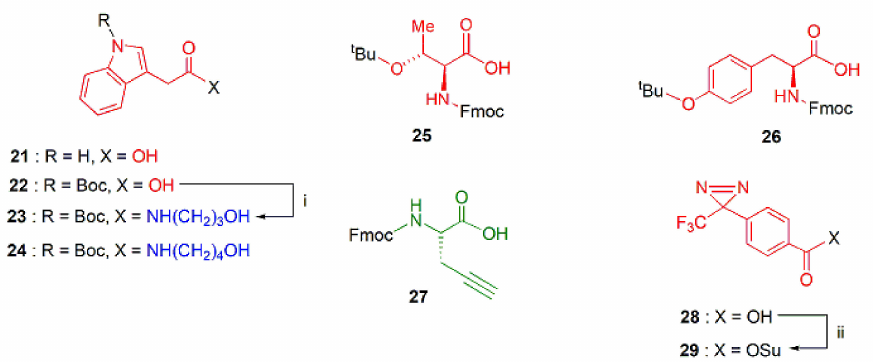
Figure 4. Structures of compounds suitable for the attachment of the lipophilic head groups to the PA chains. Reagents and conditions : (i) HOSu/DCC, DMF, 0 ◦ C, 30 min then 25 ◦ C, 2 h, followed by addition of H 2 N(CH 2 ) 3 OH, 25 ◦ C, 10 min, 80%; (ii) HOSu/DCC, THF, 0 ◦ C, 30 min then 25 ◦ C, 2 h,